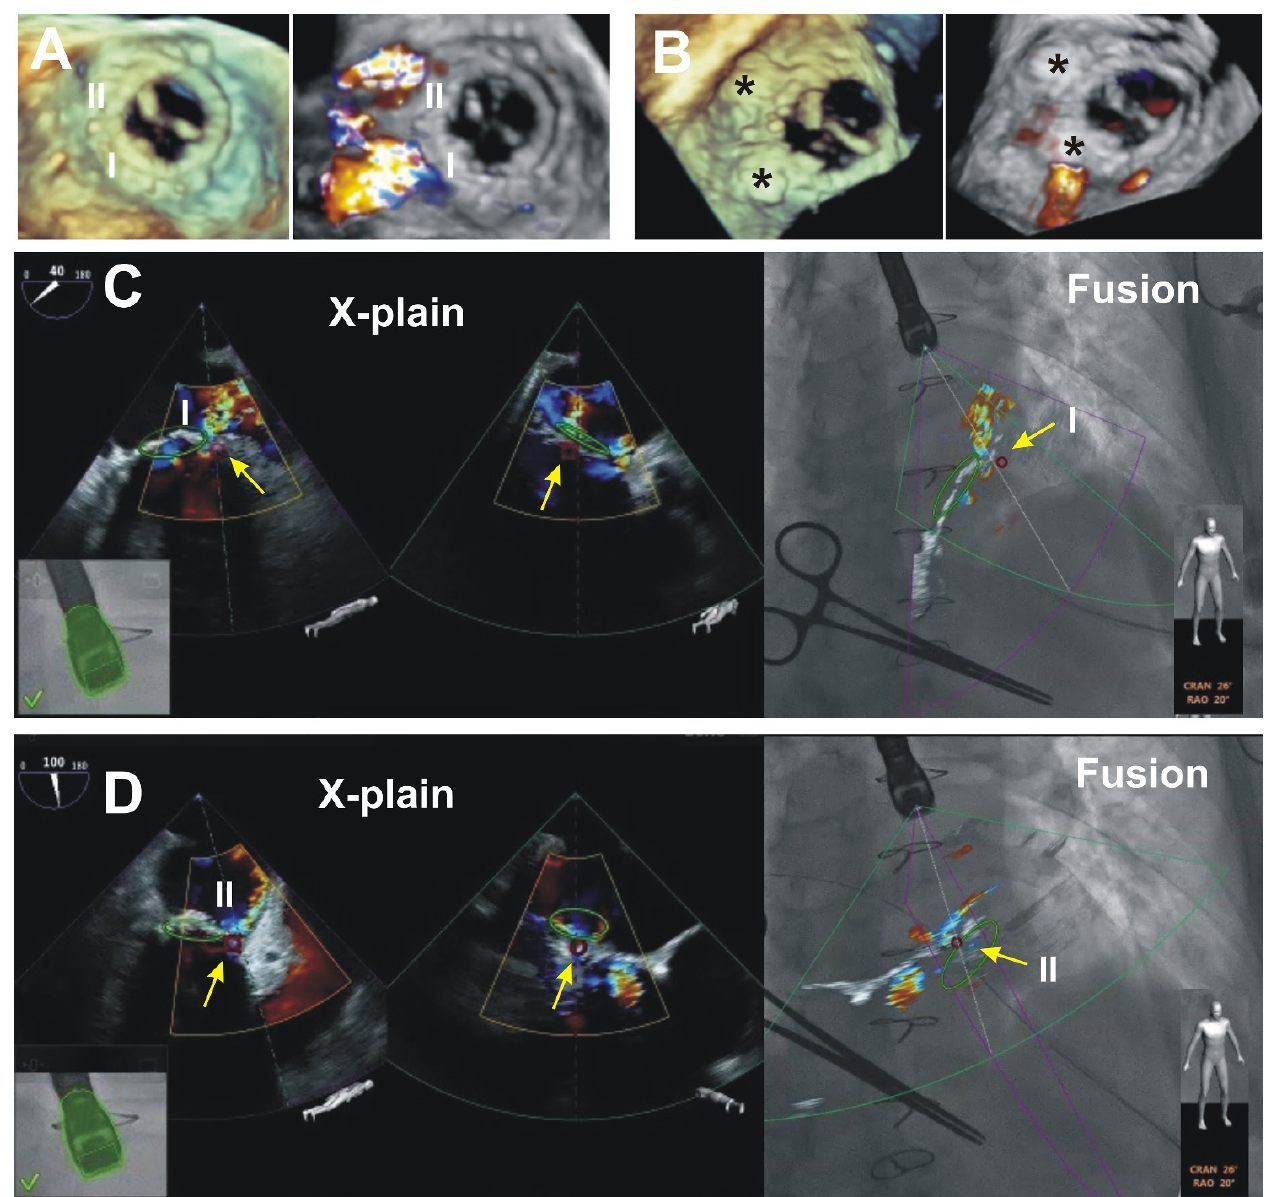
Figure 2. An example of EFF scenario A “Side view of the TEE probe”. The position of the C-arm at 26° Cran, and 20° RAO, TEE probe is seen obliquely—from the side and the top. The automatic recognition of the TEE probe by EchoNavigator ® -system software is highlighted by the green contouring. ( A , B ) preprocedural and postprocedural 3D and 3D Color Doppler TEE images of the biological prosthesis from the surgical perspective. I and II—paravalvular regurgitant jets show the location of two PVLs at 8 and 10 o’clock ( A ). Black stars mark PVL occluders with a small residual regurgitant jet near the first occluder ( B ). ( C , D ) intraprocedural EFF images for the closure of the I and II PVLs. Two X-plain (perpendicular to each other) 2D TEE views with Color Doppler cross the I and the II PVLs and regurgitant jets on the left. 2D TEE views planes seen on EFF images tilted in space. In addition, the X-plain views used to construct the markers transferred onto the EFF images (on the right). Green circle—sewing ring of X-ray negative biological valve prosthesis, small red ring (yellow arrows) placed at the PVLs.